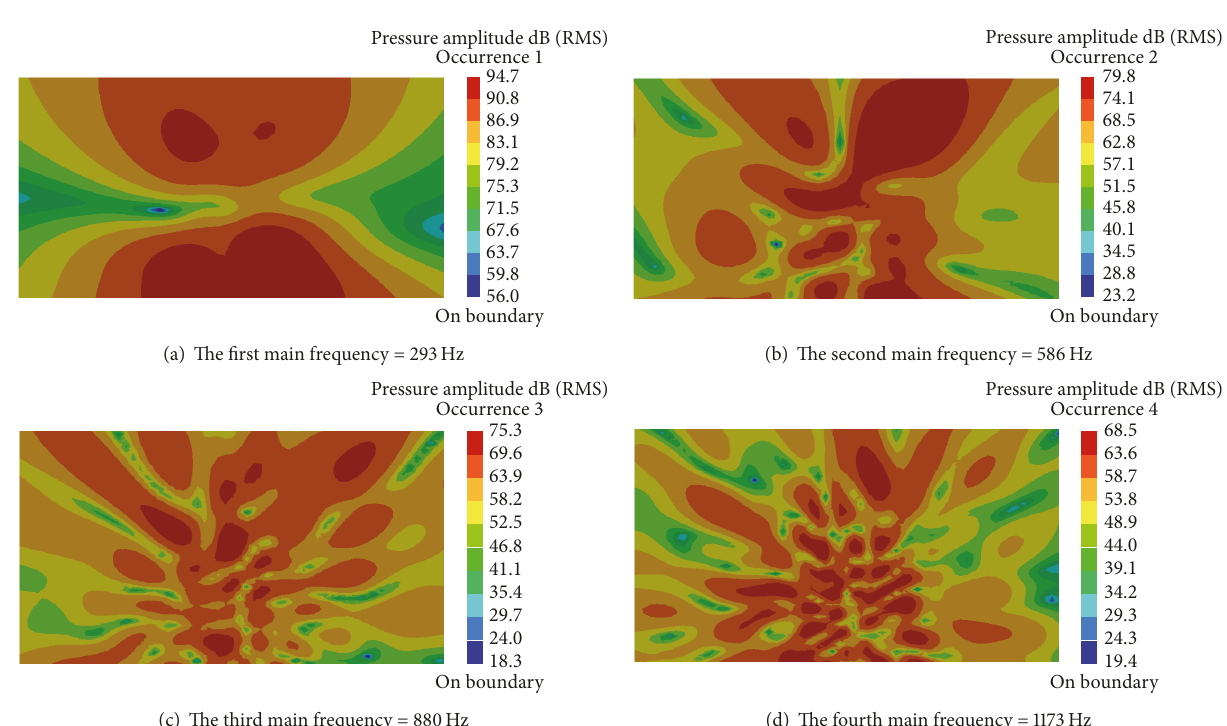
Figure 15: Aerodynamic noise radiation of pantographs in high-speed